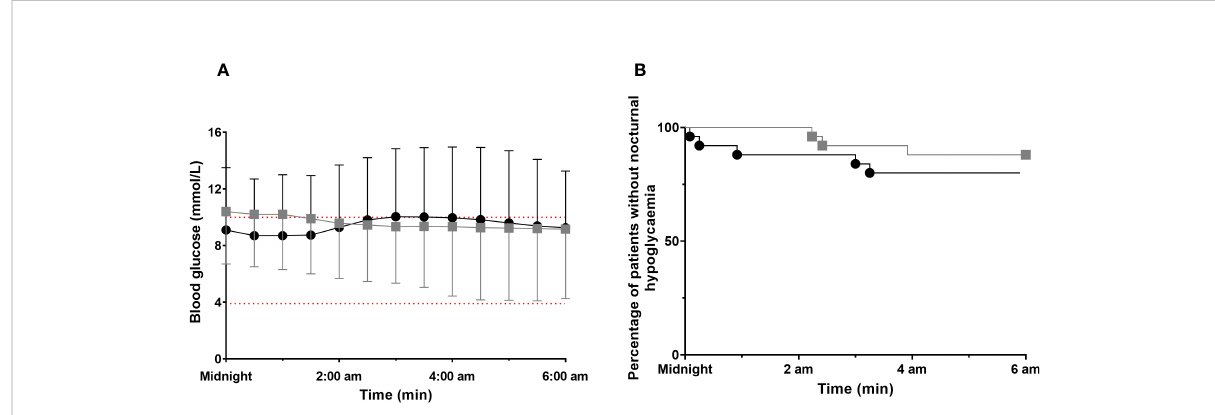
FIGURE 2 Nocturnal glucose pro fi les for both conditions (ACT vs. L-ACT) ACT, black circle; L-ACT, gray squares. (A) Glucose pro fi les from midnight to 6:00 am for both conditions. Values are means ± SD, Main effects by linear model time (P<0.001); condition ACT vs. L-ACT (P<0.001) and interaction (time x group) (P<0.001). (B) Time to fi rst nocturnal hypoglycemic event.